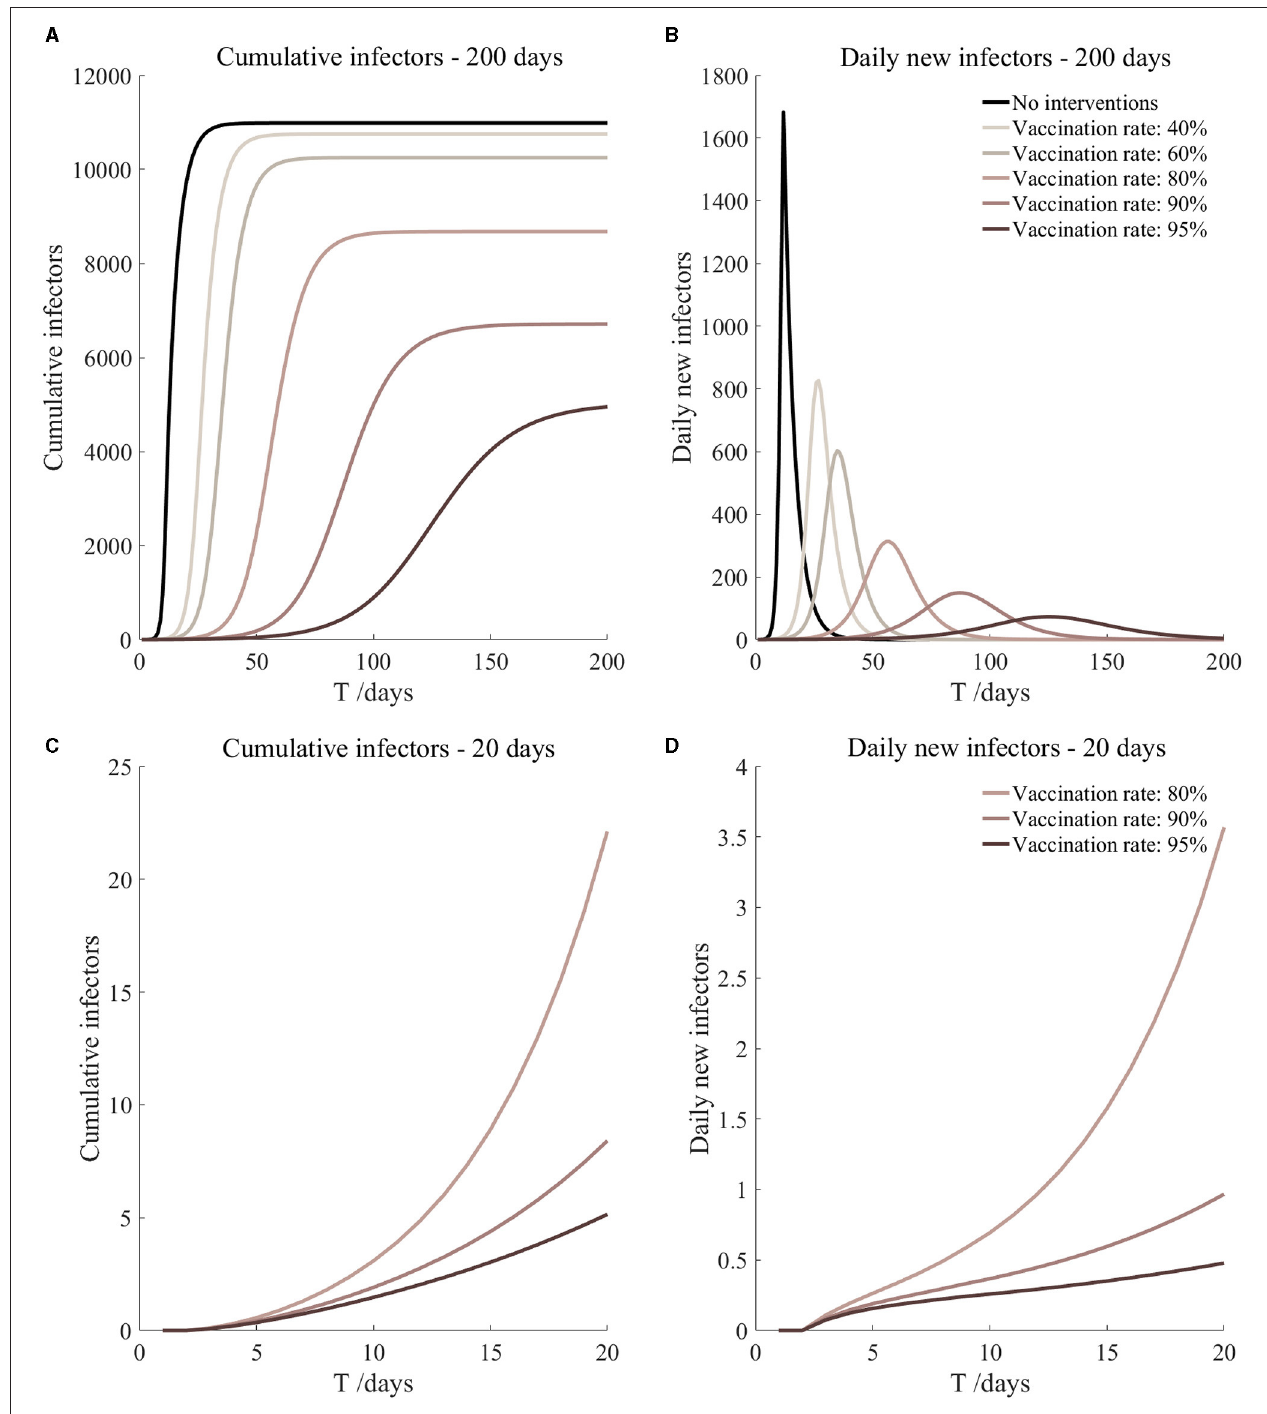
FIGURE 5 | Vaccinated but not quarantined. Assume pre-flight screening can identify 20% of asymptomatic infectors.